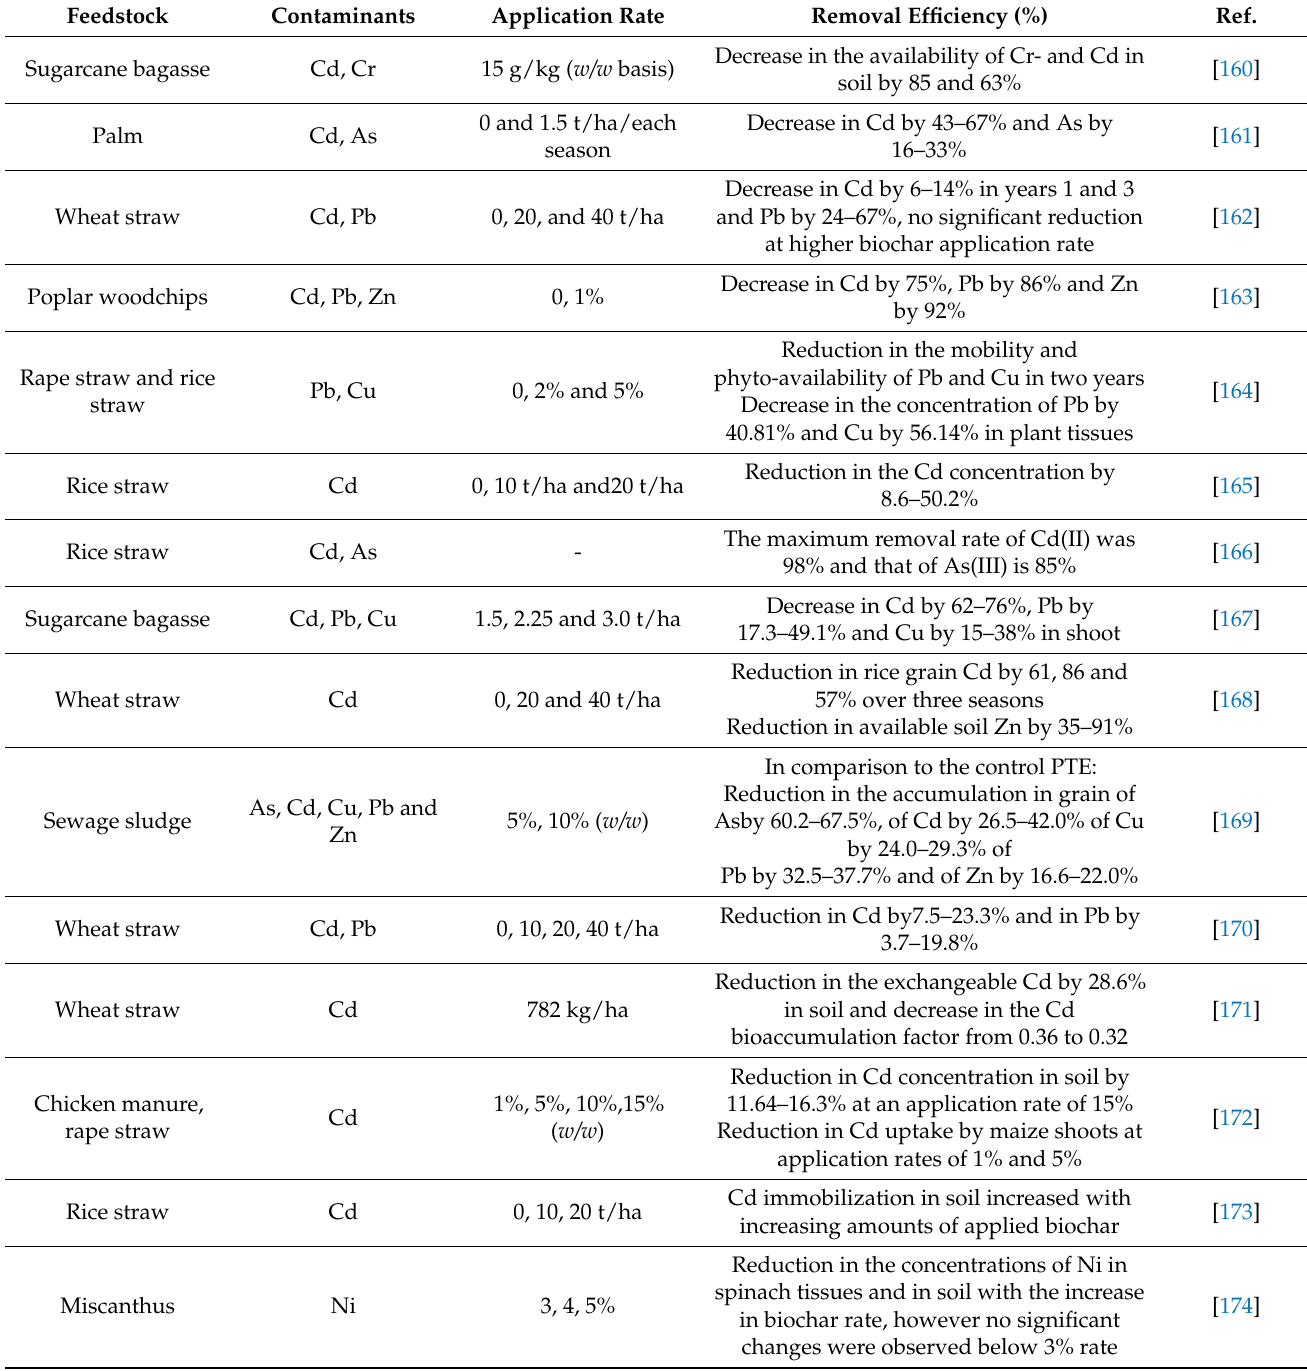
Table 3. Removal of heavy metals from soils at different rates of biochar